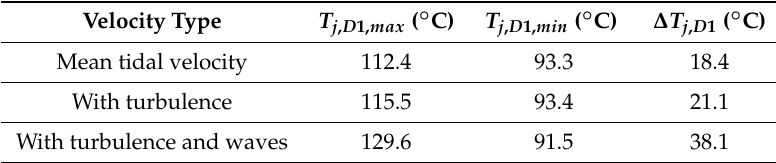
Table 9. Diode Temperatures corresponding to Figure